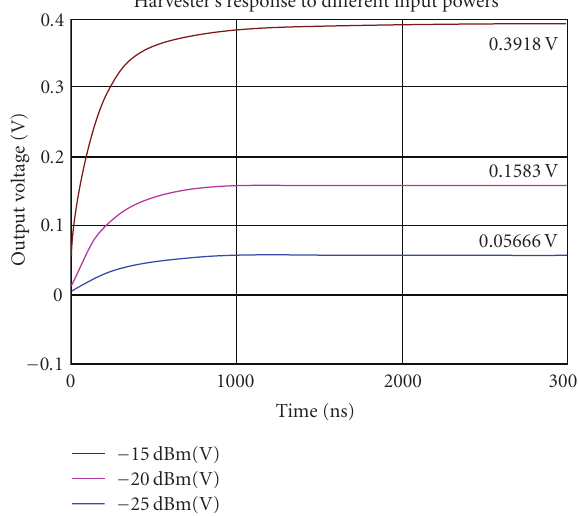
Figure 9: Di ff erent capacitances for Villard multiplier.